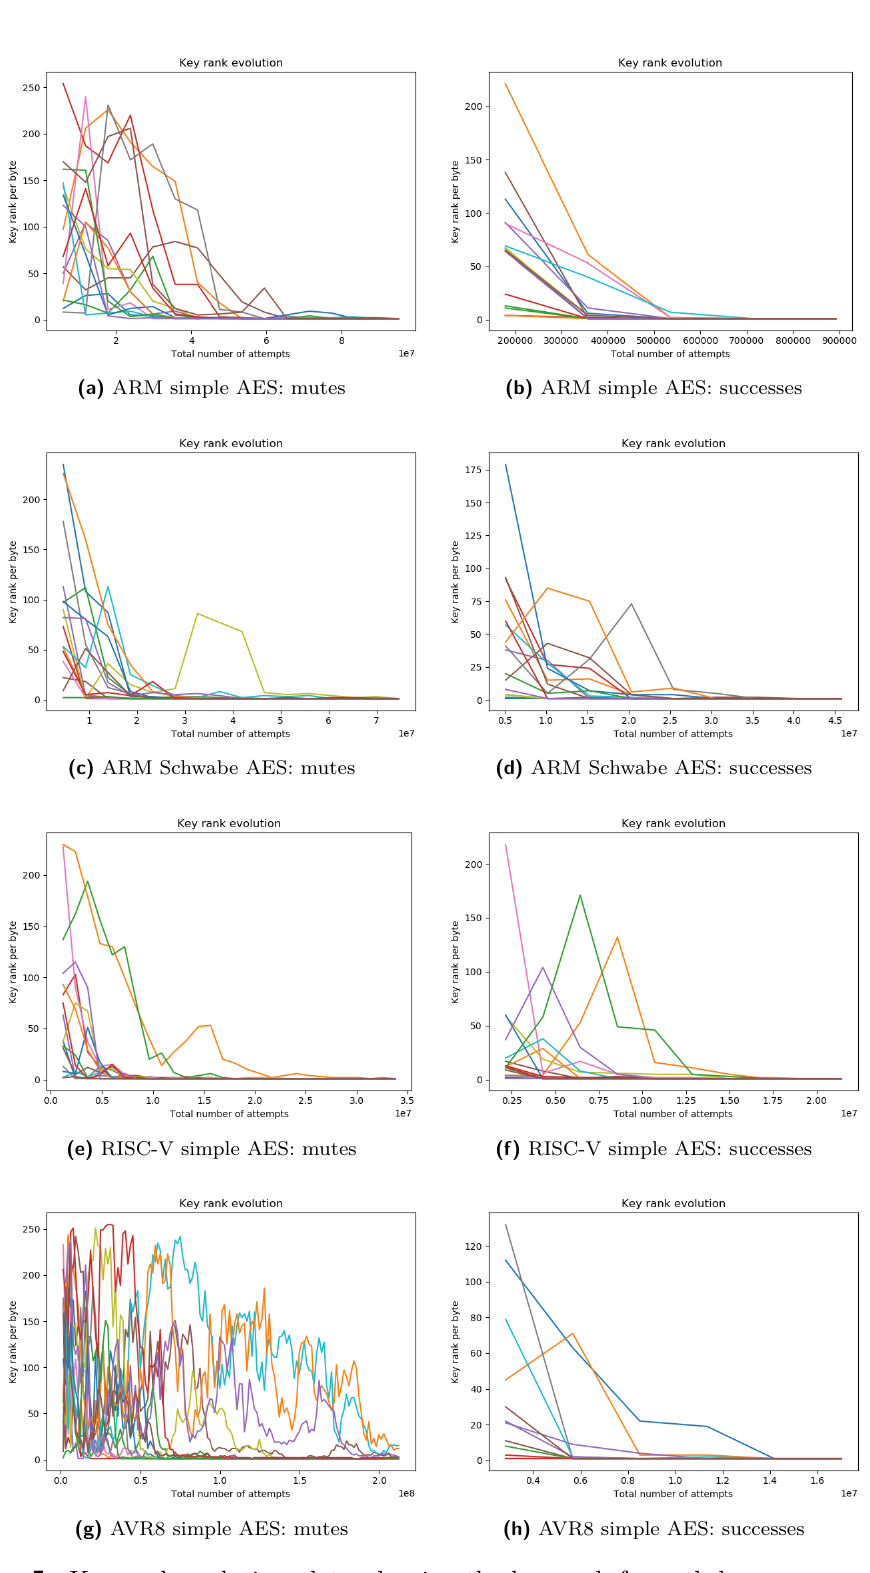
Figure 5: Key rank evolution plots, showing the key rank for each key guess vs. the number of attempts. Note that the x-axis scales can differ by an order of